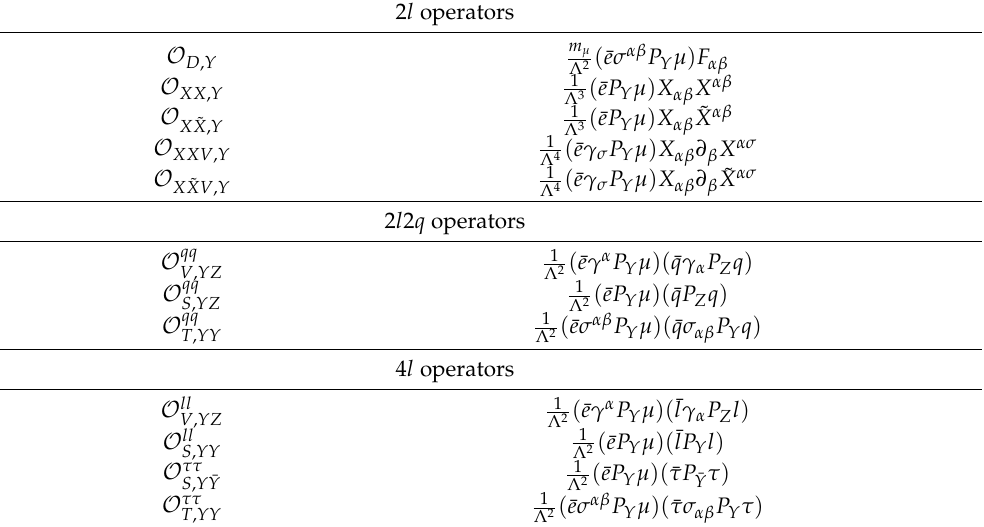
Table 2. Low-energy QCD ⊗ QED invariant EFT for µ → e , µ → 3 e and µ → e conversion in nuclei, in the notation of [119]. The experiments can be sensitive to three, four point functions that correspond to operator of dimension five, six and seven. X αβ = F αβ , G αβ are the field tensors of photon and gluons, respectively. The chiral projector P Y , Z can be Y , Z ∈ { L , R } , ¯ L = R , ¯ R = L , while q ∈ { u , d , s , b , c } and l ∈ { e , µ , τ } . 2 l